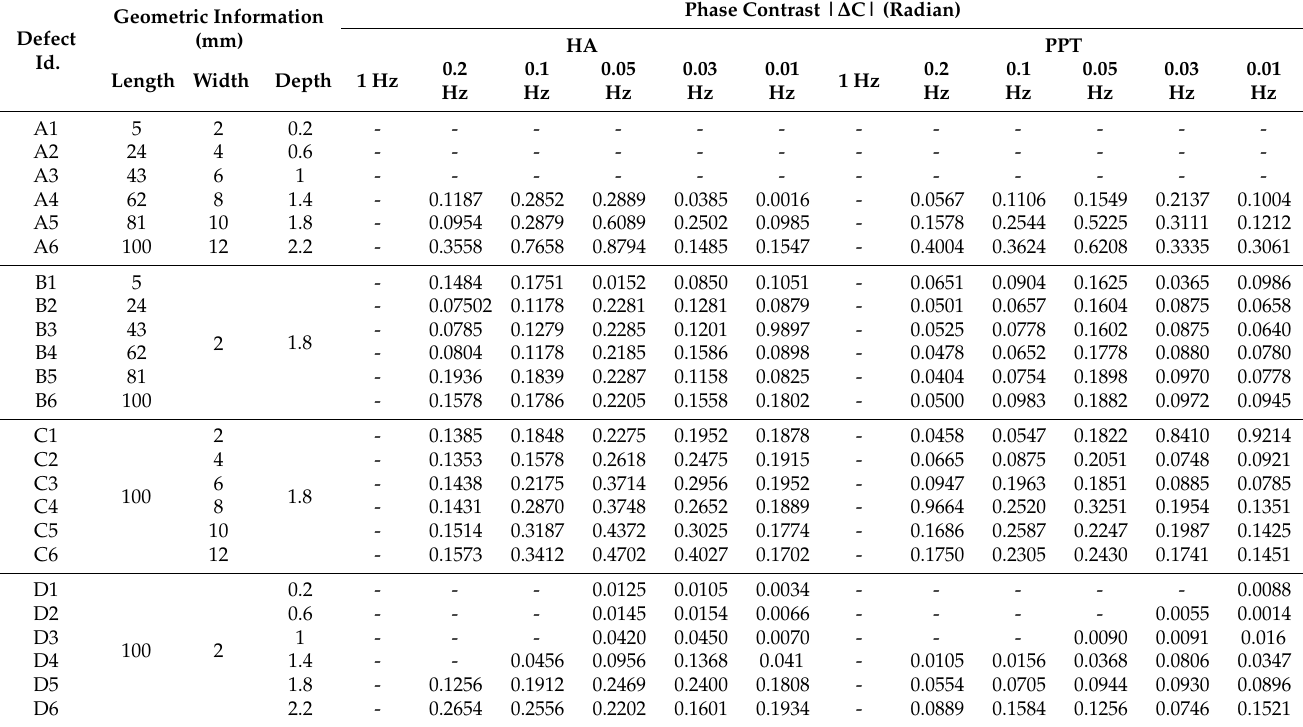
Table 4. Phase contrast results for each algorithm according to the modulation